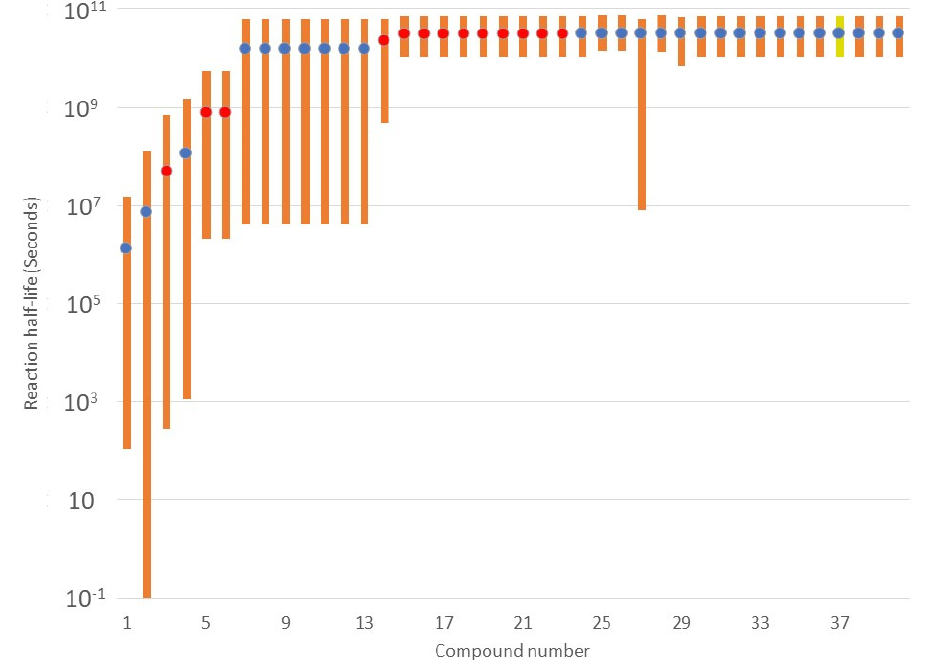
Figure 4. Half of jet fuel combustion products are expected to have half-lives of over 100 days. X axis: compound number as listed in Table 1. Y axis: half-time to reaction with sulfuric acid under stratospheric conditions. Amber bars—range of estimated values for range of conditions. Yellow bar—values for pyrene, whose stability is over-estimated by this model. Circles: average values–red = compounds containing no carbon-carbon double bonds (e.g., alkanes). Blue = compounds containing carbon-carbon double bonds (e.g., alkenes). The full table of data is provided in Supplementary